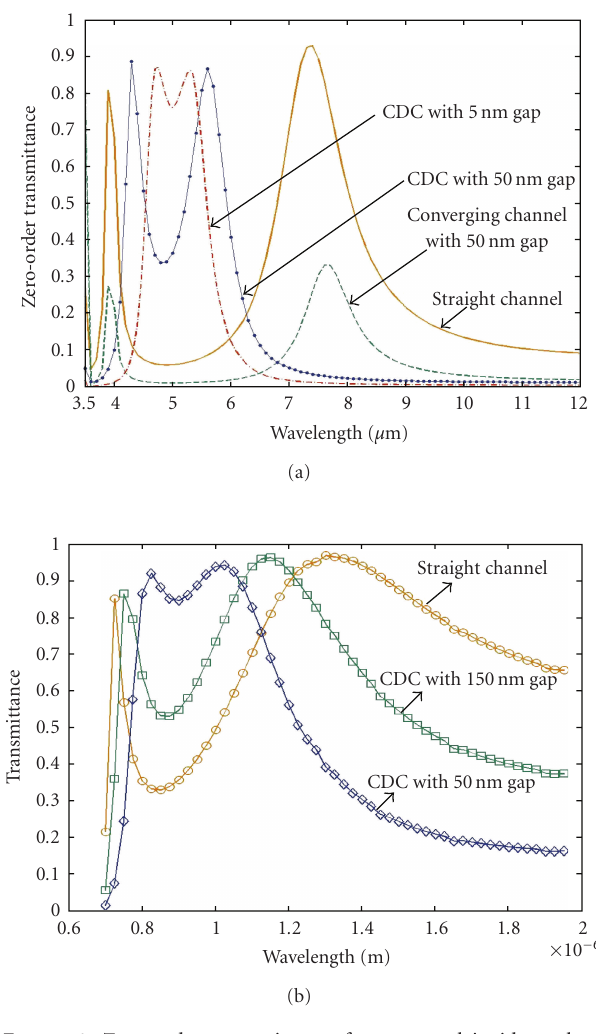
Figure 2: Zero-order transmittance for a normal incident plane wave on lamellar gratings in vacuum for di ff erent channel config- urations, but with the same grating parameters as (a) d = 3.5 μ m, a = 0.5 μ m, and t = 3.0 μ m in gold film; (b) d = 650 nm, a = 300 nm, and t = 500 nm in silver